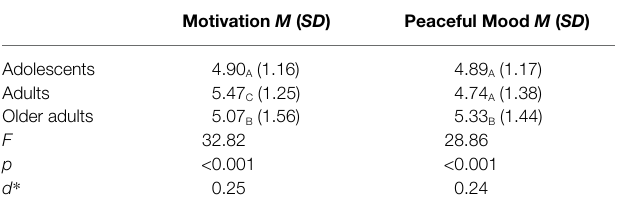
TABLE 2 | Self-reported well-being for each of the three age groups.